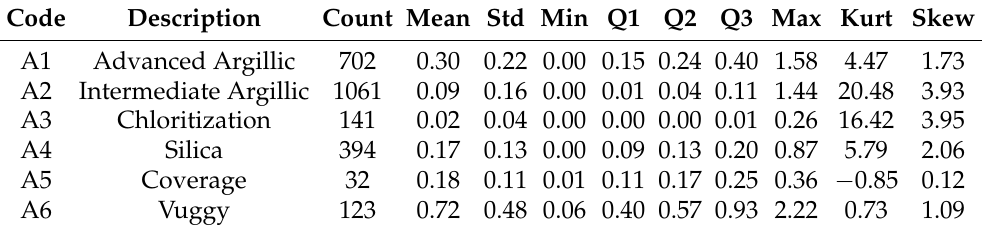
Figure 3. Normal probability plot of gold grade by mineral zone. Table 3. Au statistics (ppm) by type of